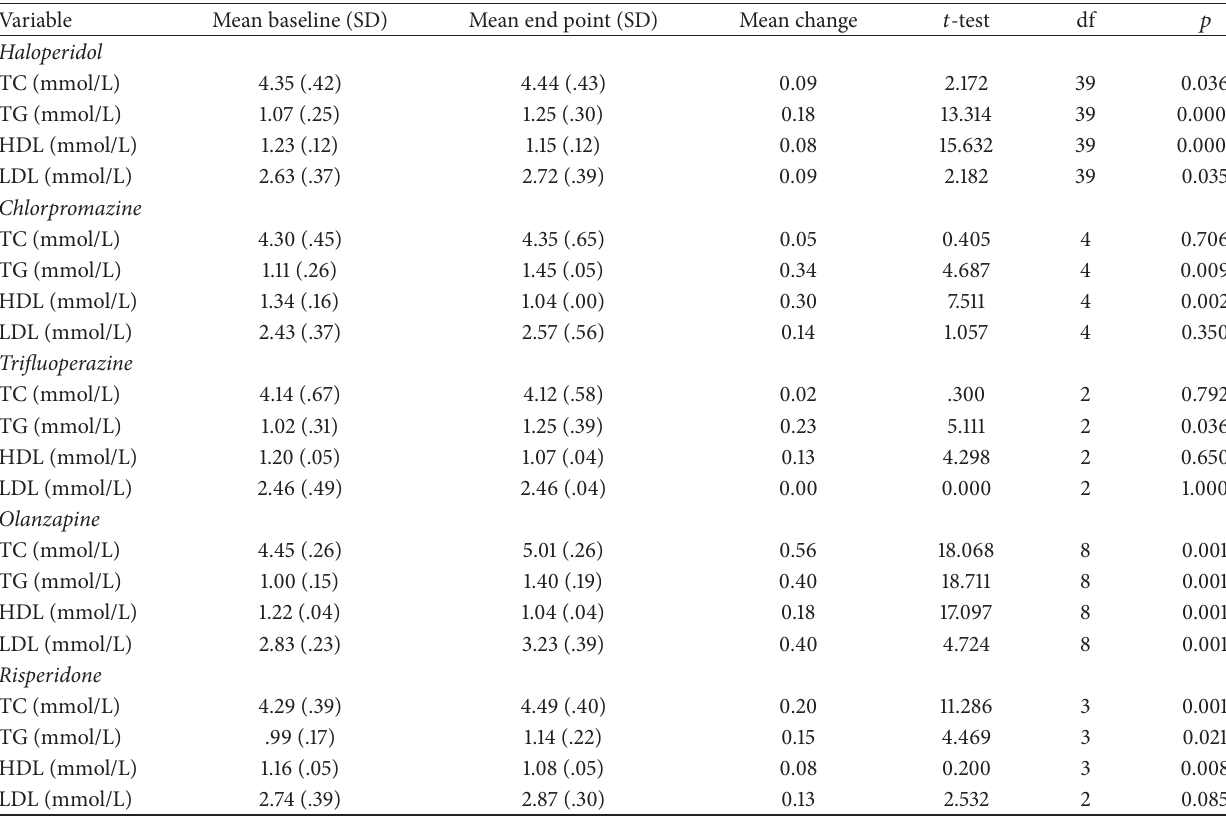
Table 2: Individual antipsychotics and change in lipid